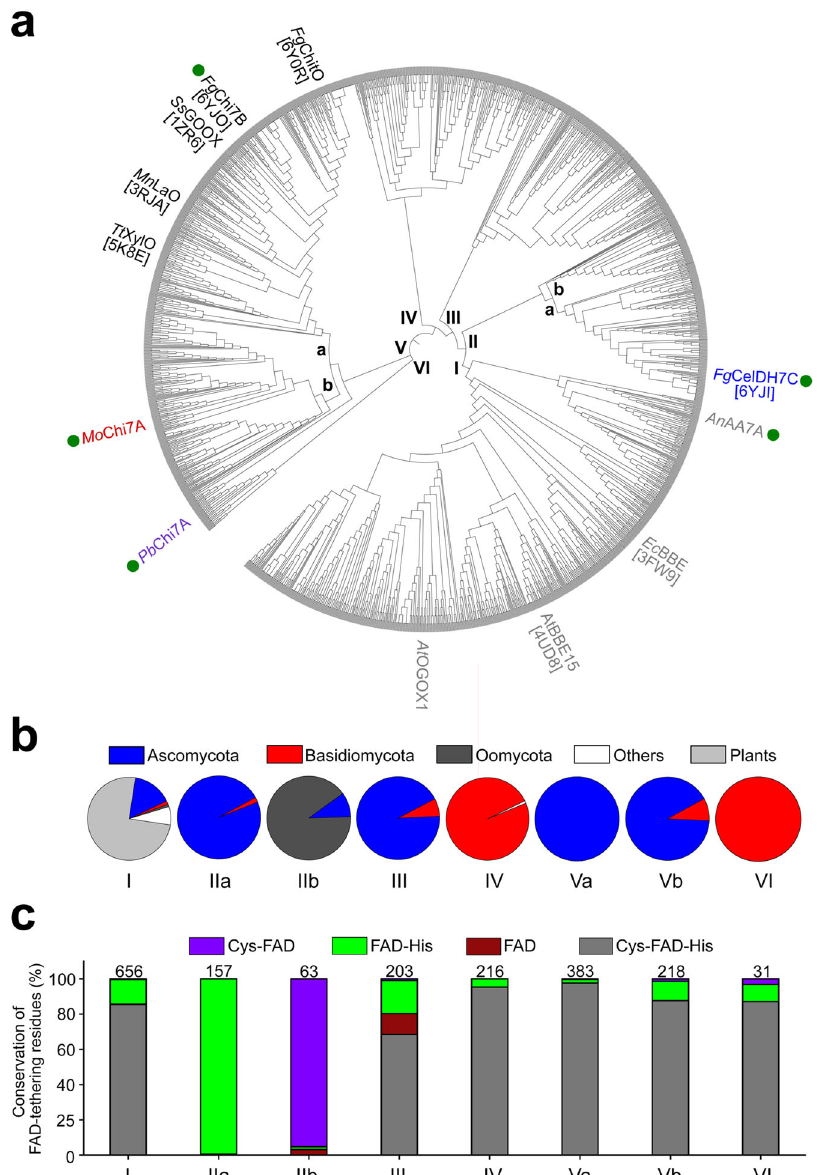
Fig. 1 Phylogenetic analysis of AA7-like sequences. a The phylogenetic tree is based on 1927 sequences. Biochemically characterized enzymes are coloured according to clade, with green circles indicating enzymes from the present study. The PDB entries (in square brackets) are given for available enzyme structures. Clade Va harbours the canonical previously described oligosaccharide oxidases: Ss GOOX 15 from Sarocladium strictum active on cellooligosaccharides, Mn LaO 16 from Microdochium nivale active on lactose, Tt XylO 17 from Thermothelomyces thermophilus active on xylooligosaccharides and Fg ChitO 18 from Fusarium graminearum active on chitooligosaccharides. Clade I contains characterised plant enzymes 33,39 that are not assigned in AA7 including the oligogalacturonide oxidase ( At OGOX1) 13 from Arabidopsis thaliana 13,33,39 . b Clade-wise taxonomic distribution of putative AA7 sequences. c Clade-wise conservation percentage of the histidine and cysteine FAD-cofactor tethering residues. The number of sequences within each clade is indicated above each bar. The accessions of the sequences in the tree are provided in the Source Data fi